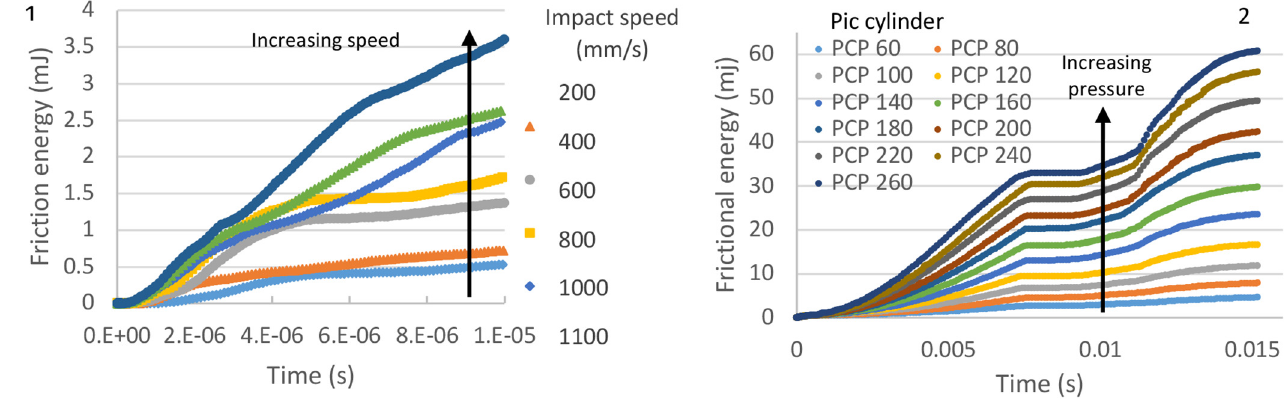
Fig. 21. Friction energies comparison between the impact (1) and the combustion (2).